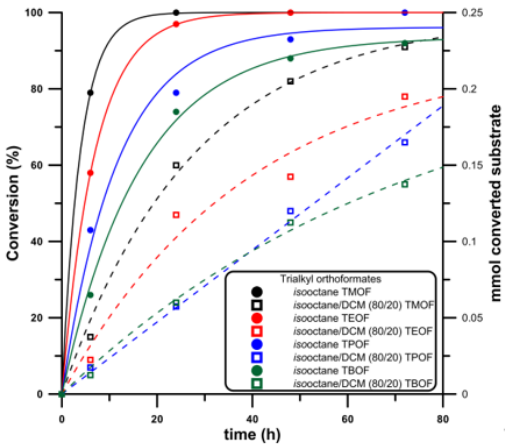
Figure 6. Kinetics of the esterification of rac -ibuprofen with different alkyl orthoformates using pure isooctane and isooctane/DCM 80/20 ( v / v ). Experimental data in Table 3. Table 3. Effect of the chain length of alkyl orthoformates on the kinetic resolution of rac -ibuprofen in isooctane/DCM.